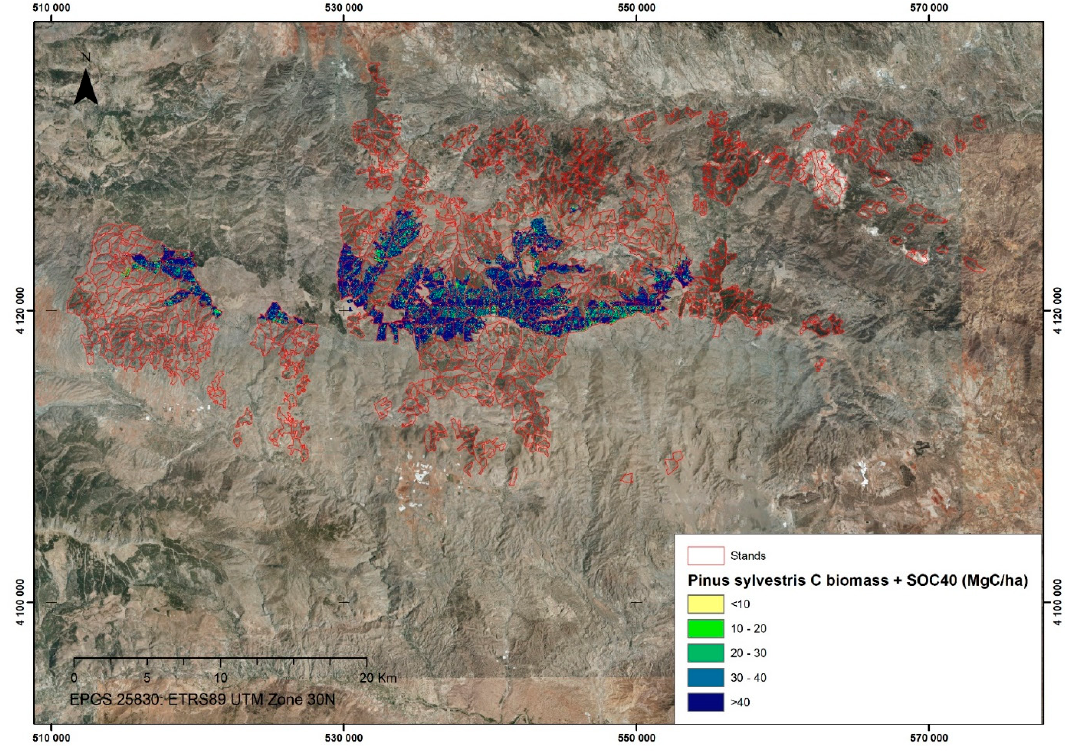
Figure 7. Cartography of the C stocks in Pinus sylvestris plantations at Sierra de los Filabres (Southern Spain).